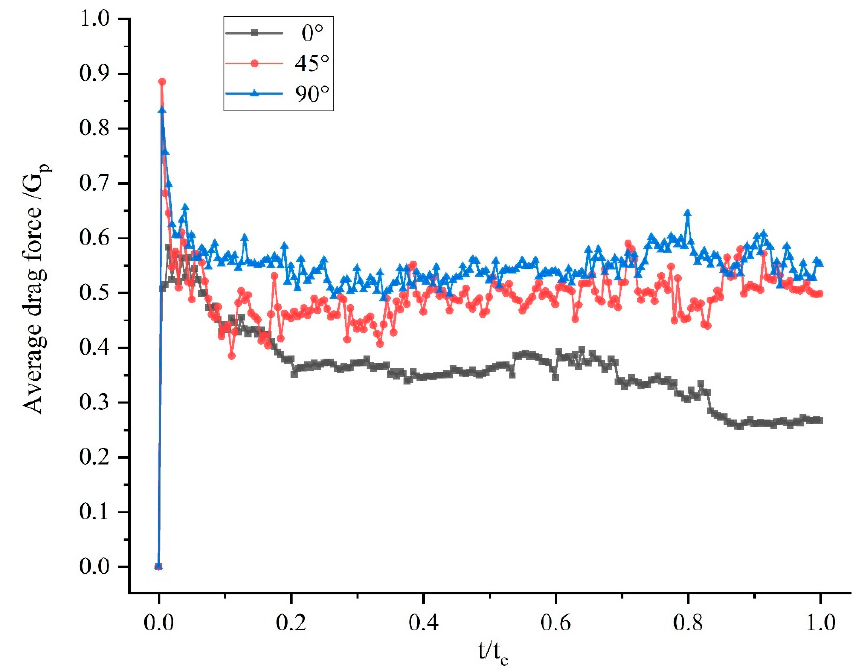
Figure 14. Average drag time history.